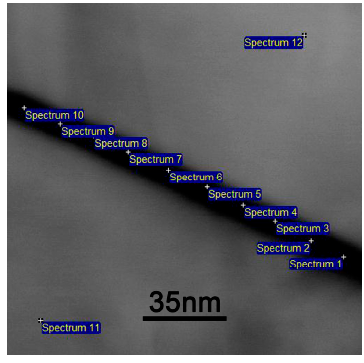
Figure 5. FEGSTEM image showing a segment of grain boundary analyzed.